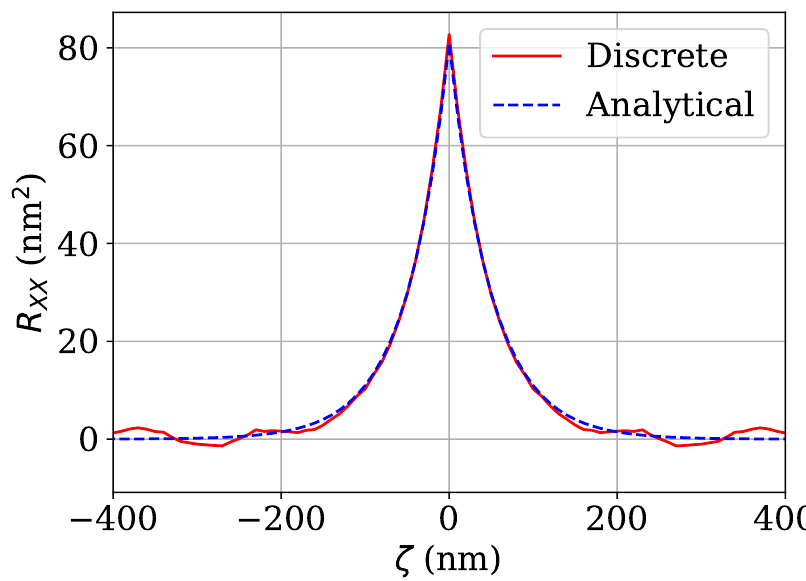
Figure 2. Example ACF with input parameters σ = 9 nm and L c = 50 nm. The discrete trace is generated with 5000